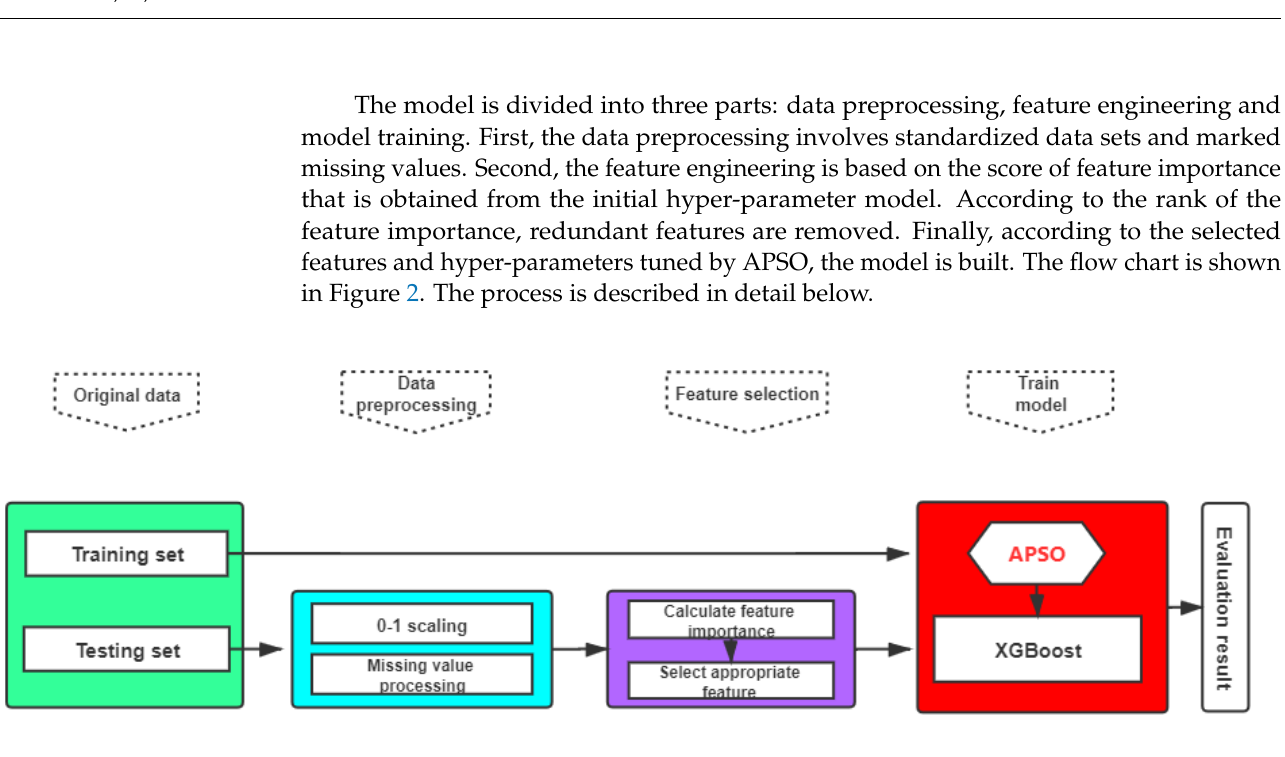
Figure 2. APSO-XGBoost credit scoring model.